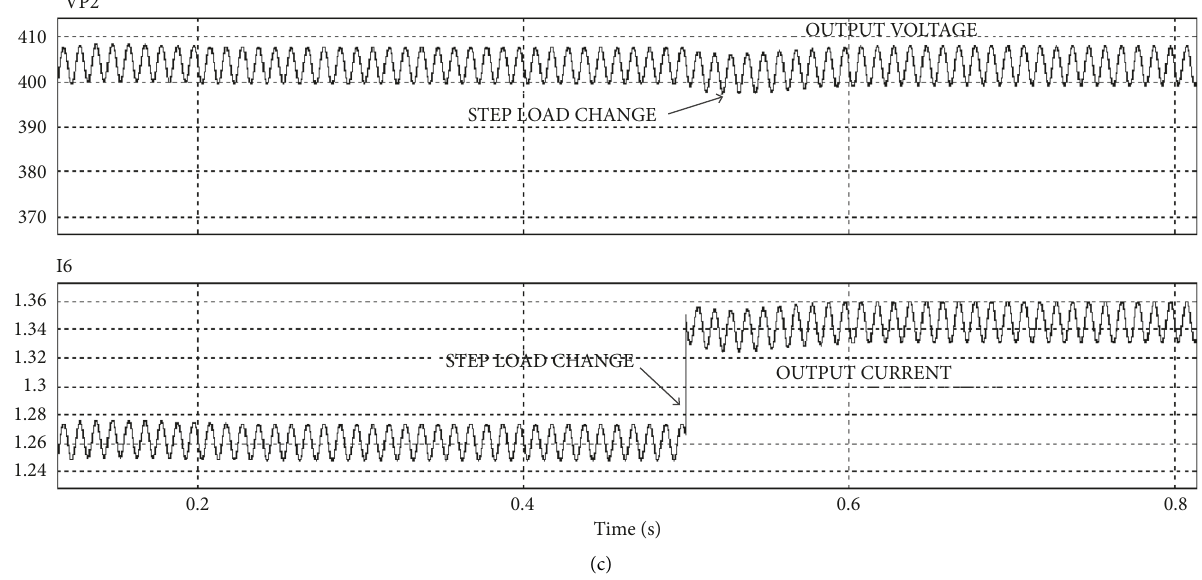
Figure 8: (a) Dynamic response of the ACM controller for step change in the load at t � 0.38s. (b) Output voltage and output current for negative step load change at t � 0 . 48 s. (c) Output voltage and output current for a positive step load change at t � 0 .